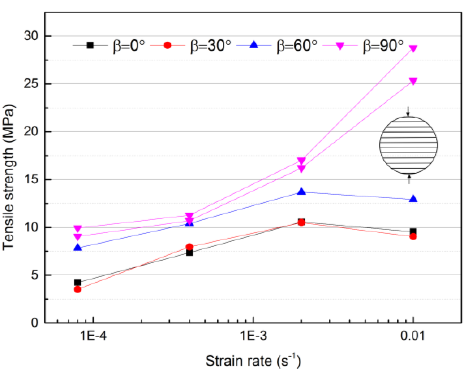
Figure 5. The relationship between tensile strength and strain rate for shale samples with different orientations.